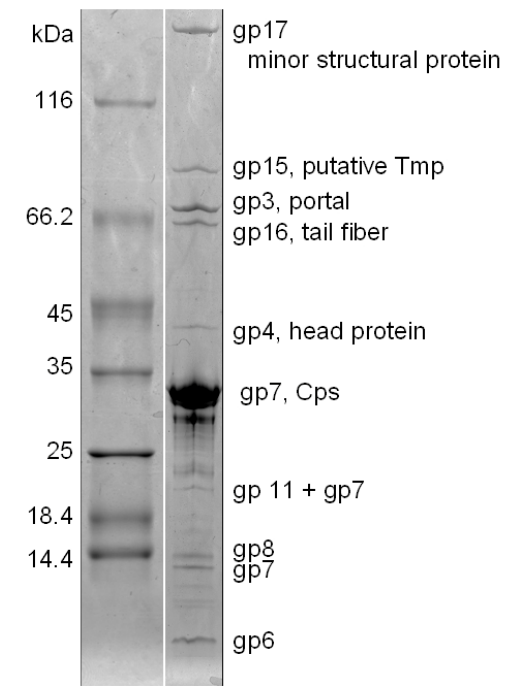
Figure 5. SDS-PAGE of TP21-L structural proteins. Left: Size Marker, molecular mass is indicated. Right: TP21-L structural proteins and their assignment as deduced from MALDI-MS/MS analysis. Abbreviations: Cps: Major capsid protein. Tmp: Tail tape measure